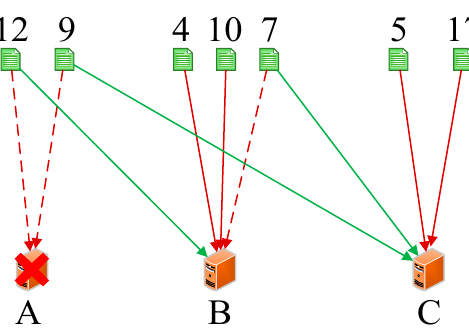
Figure 11. The changing of deploying locations of applications using the hash-based algorithm.